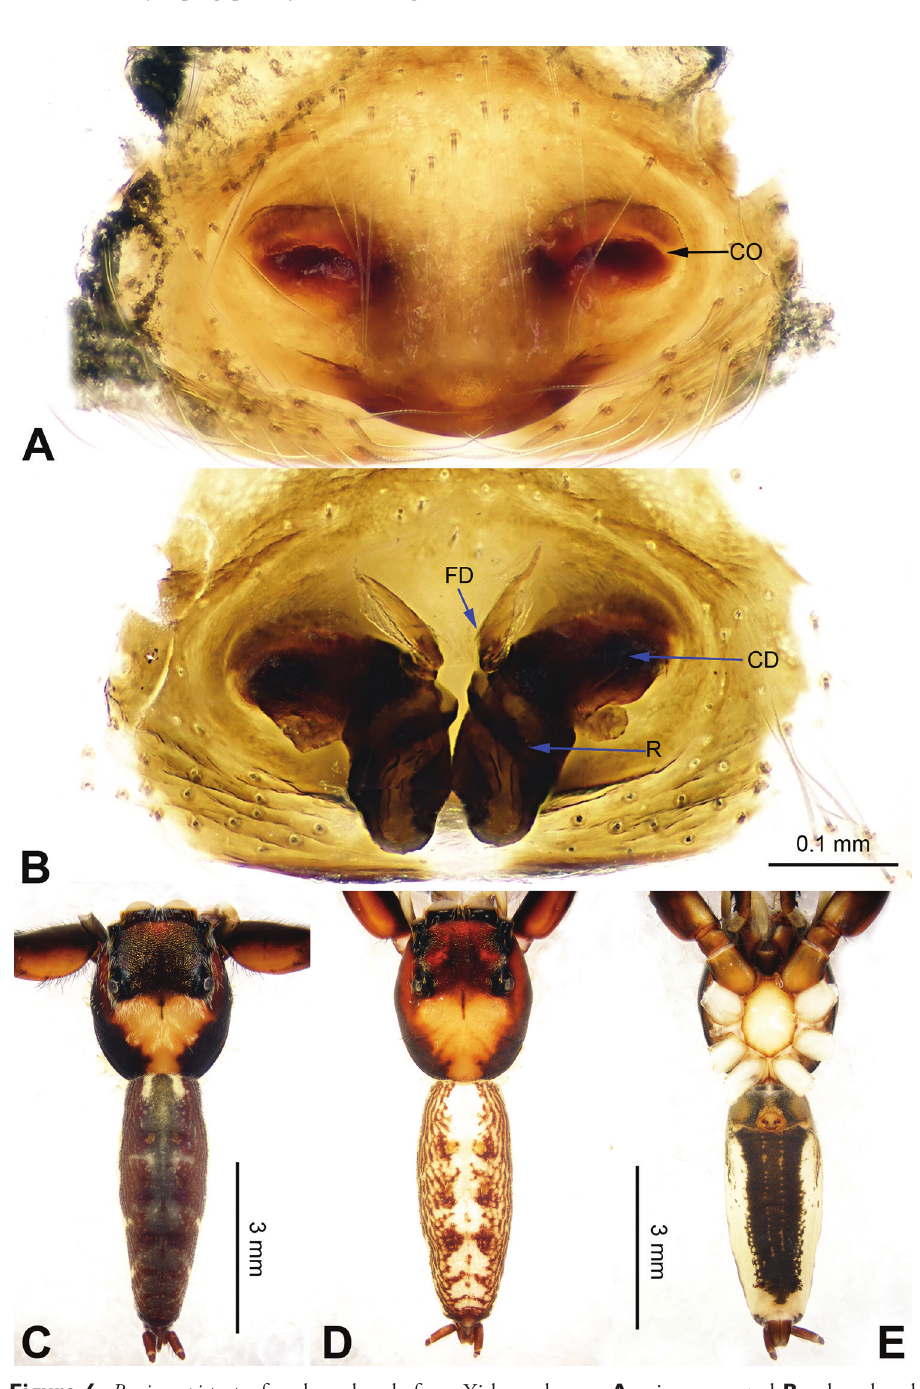
Figure 6. Bavia capistrata , female and male from Xishuangbanna. A epigyne, ventral B vulva, dorsal C male habitus, dorsal D female habitus, dorsal E female habitus, ventral. Scale bars equal for A and B ; equal for D and E